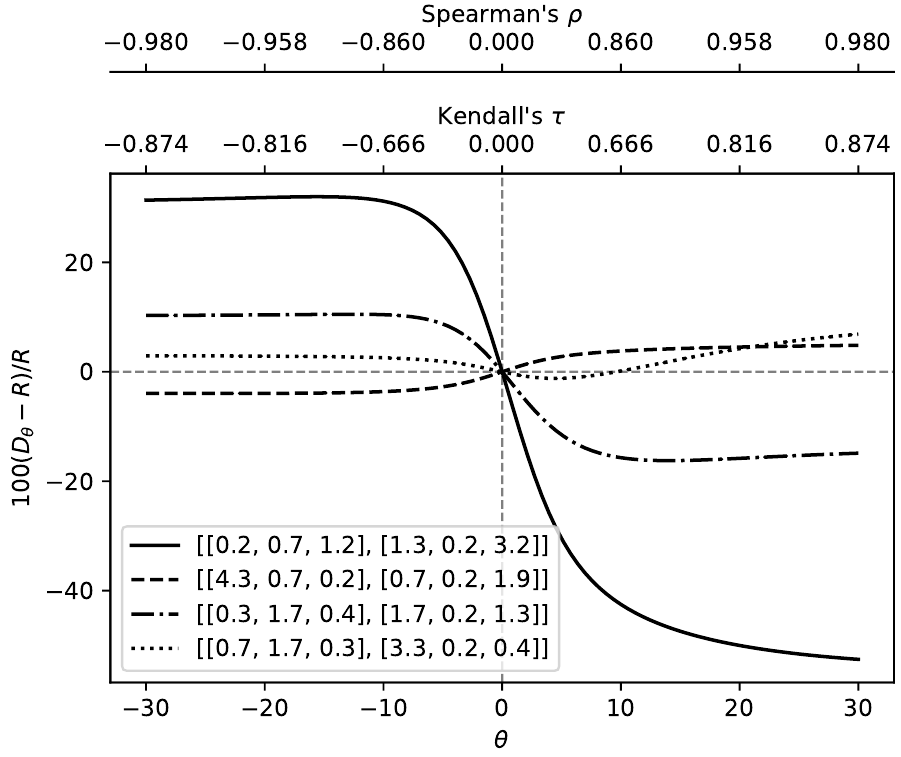
Figure 2. Percentage Values of D θ with respect to R for different random